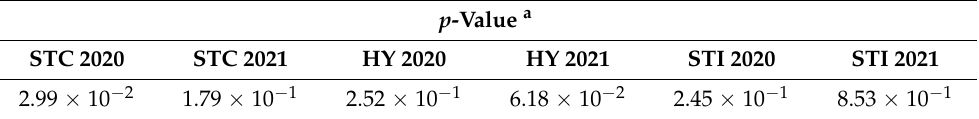
Table 3. p -Values for first principal component fixed effect in combined panel models. p -Value